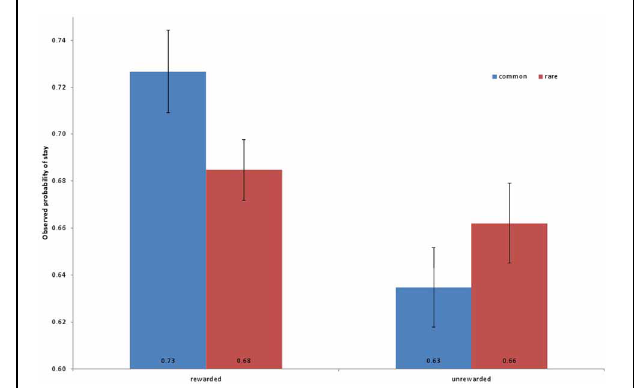
FIGURE 2 | Observed frequencies of repeating a first-stage choice in the second stage (“stay probability”) as a function of whether the previous trial’s choice was rewarded (vs. not) and the transition was common (i.e., the more likely one, given the first-stage choice) or rare. Frequencies are averaged across participants; on average, participants display evidence for both model-free learning (main effect of reward) and model-based (its interaction with